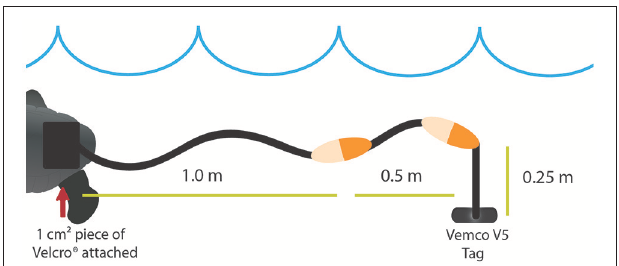
FIGURE 1 | Acoustic transmitter Velcro ® attachment method modified from Gearheart et al. (2011). Symbols are courtesy of the Integration and Application Network, University of Maryland Center for Environmental Science (ian.umces.edu/symbols/).